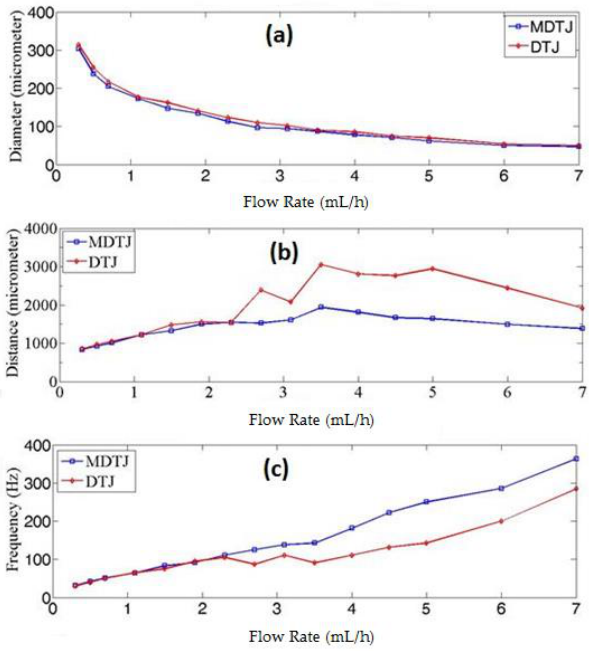
Figure 6. Three different parameters for the two geometries comparison is illustrated as follows: ( a ) droplet diameter ( b ) distance between droplets and ( c ) droplet frequency with varied oil flow rates ranged from 0.3 mL/h to 7 mL/h and fixed water flow rate a t 0.3 mL/h .